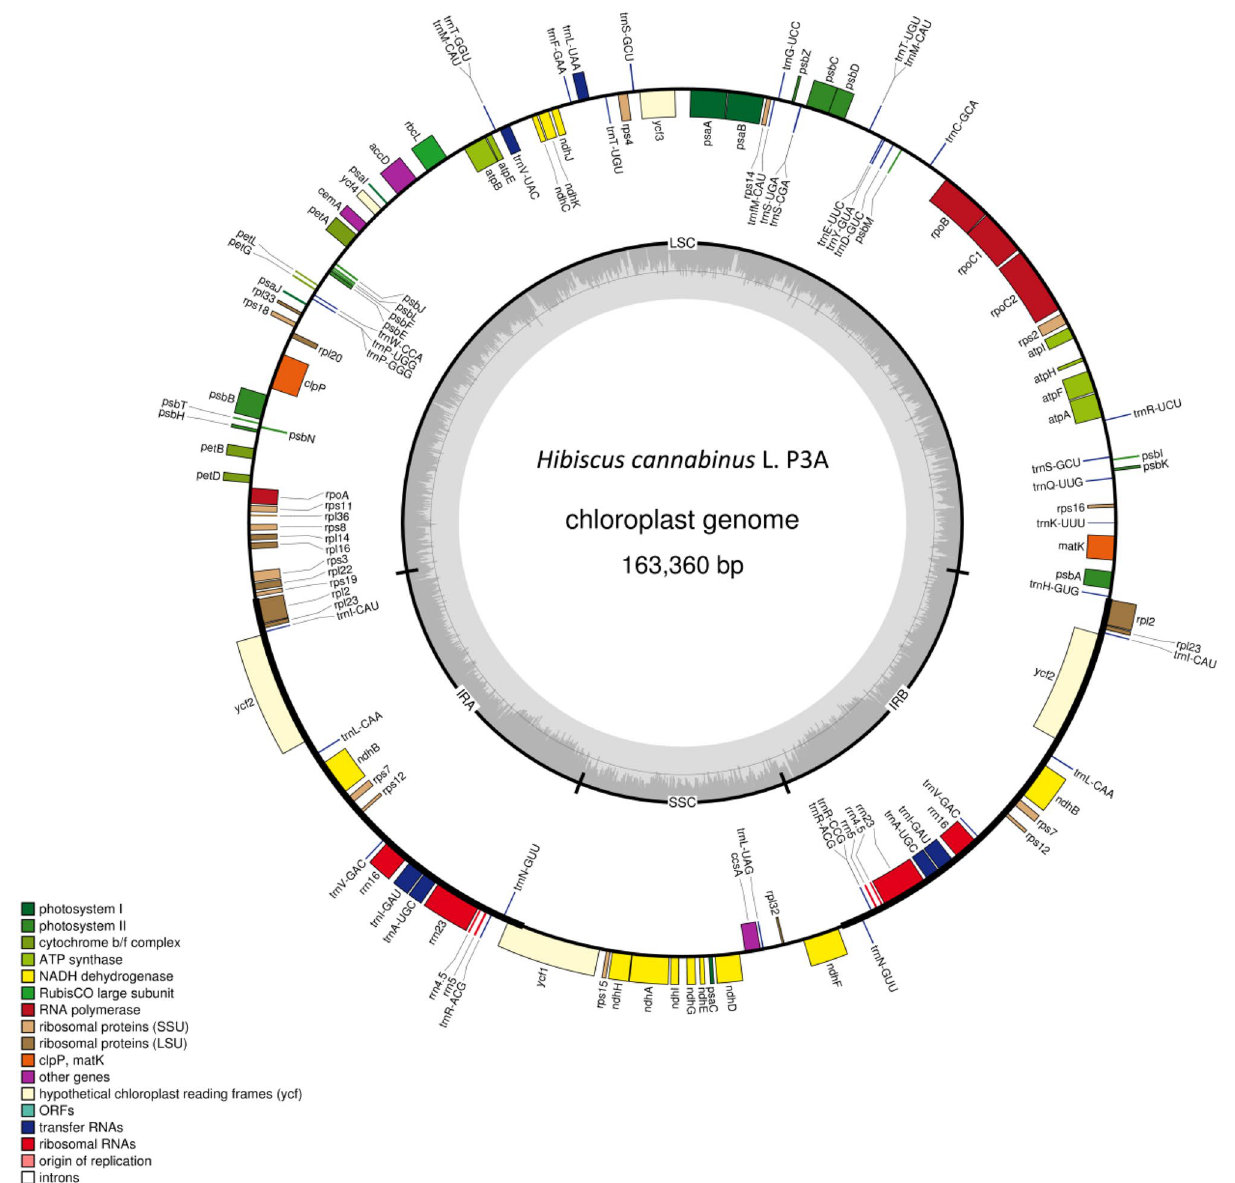
Figure 2. Circular Gene map of Hibiscus cannabinus CMS line